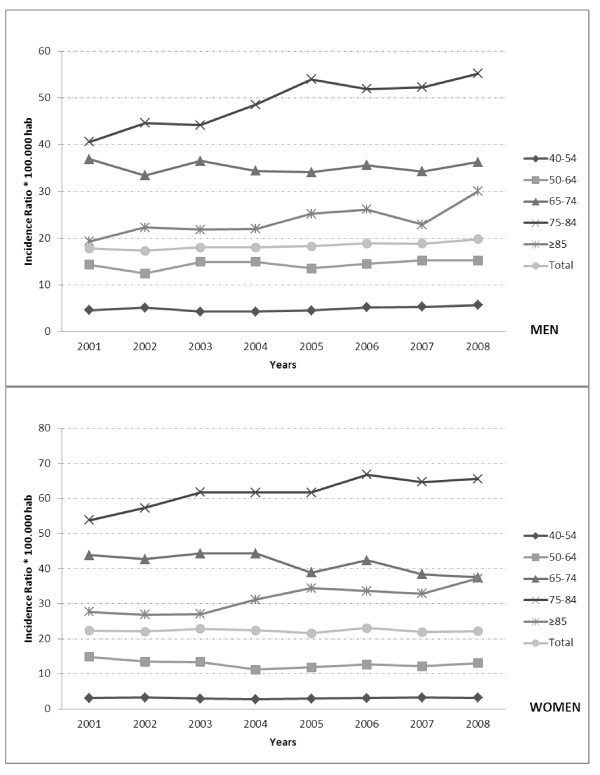
Incidence of RTHA per 100, 000 inhabitants in Spain from 2001 to 2008, according to age group and gender.